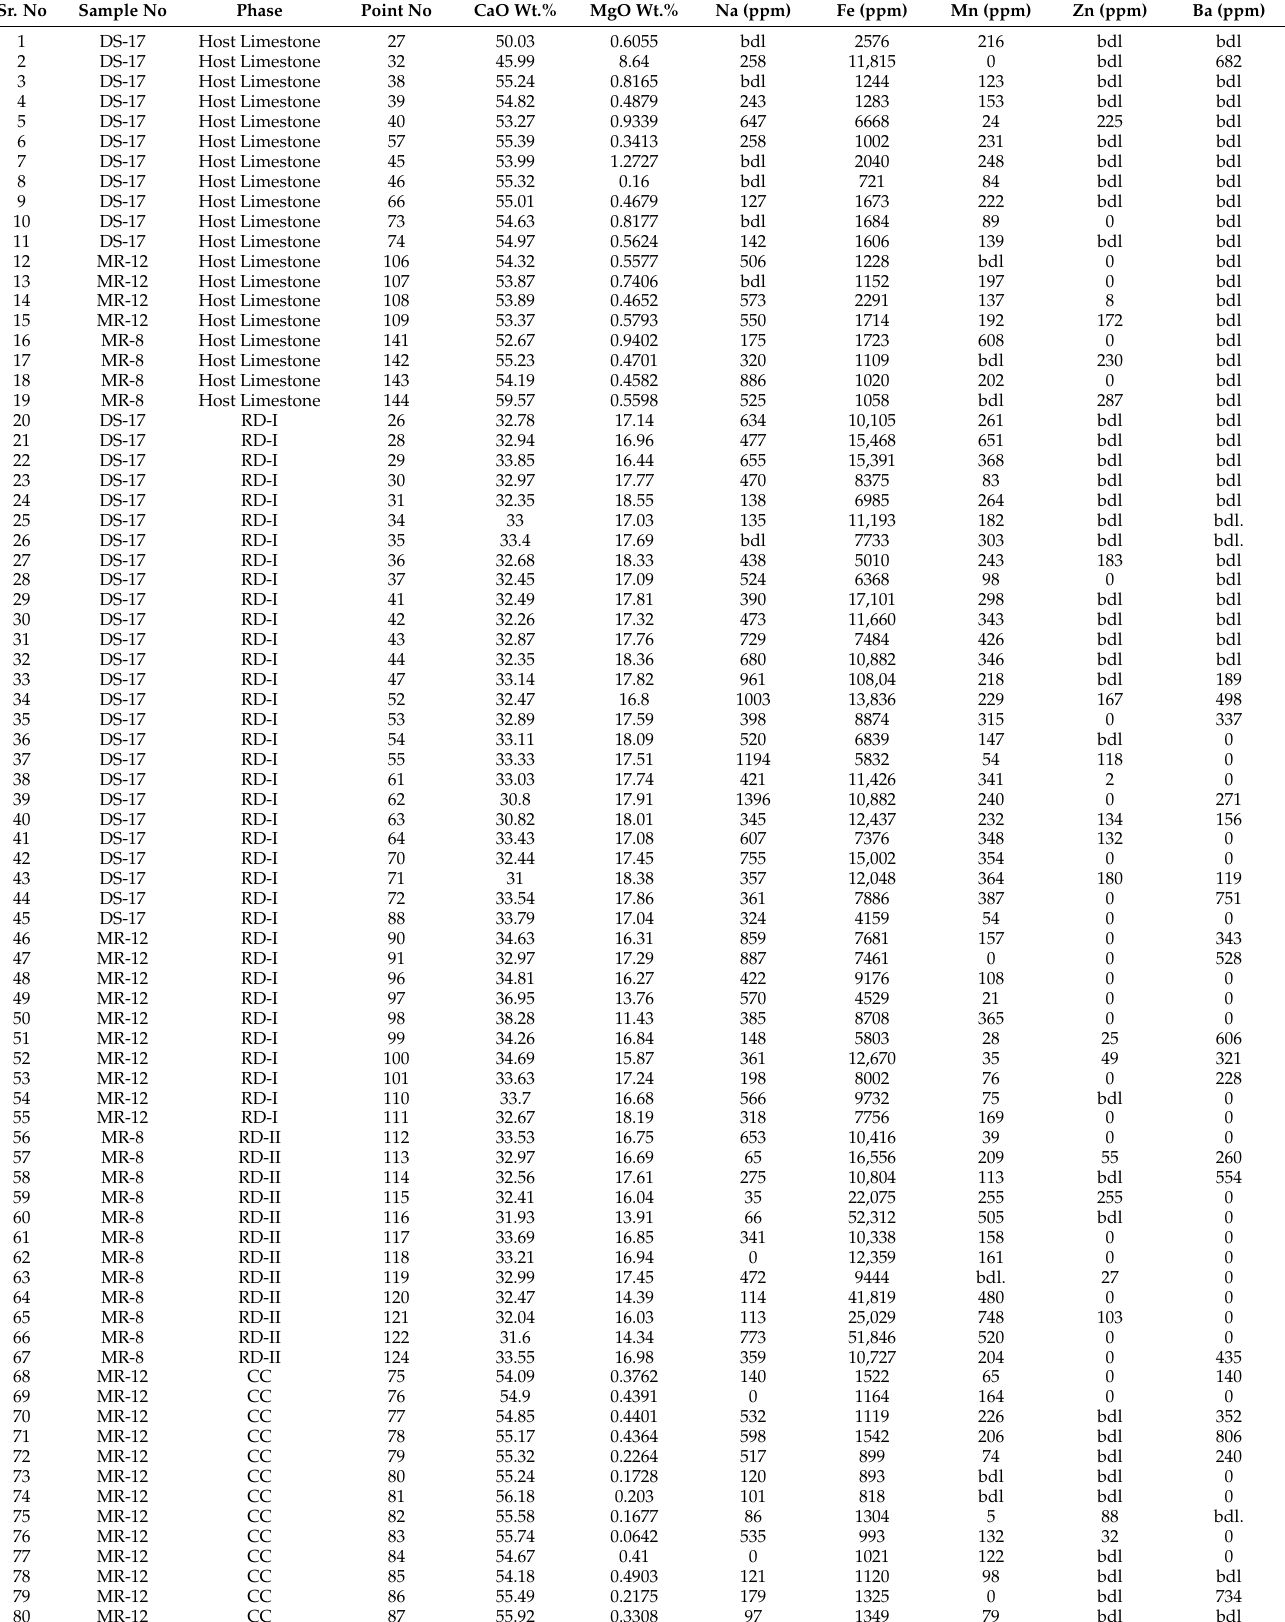
Table 1. EPMA data of limestone and dolomite phases of the Samana Suk